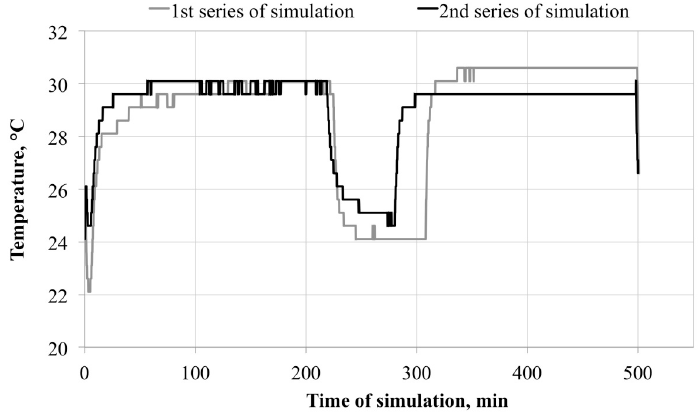
Figure 2. Temperature changes inside the FFRs during simulated breathing cycles.